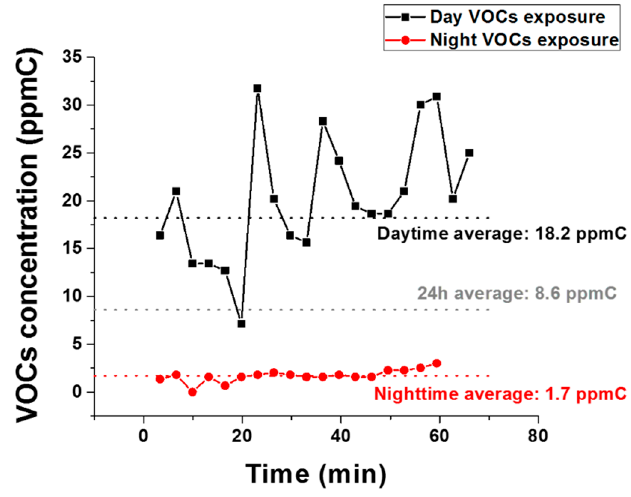
Figure 5. High VOCs exposure case. VOCs exposure concentration for the auto mechanic.